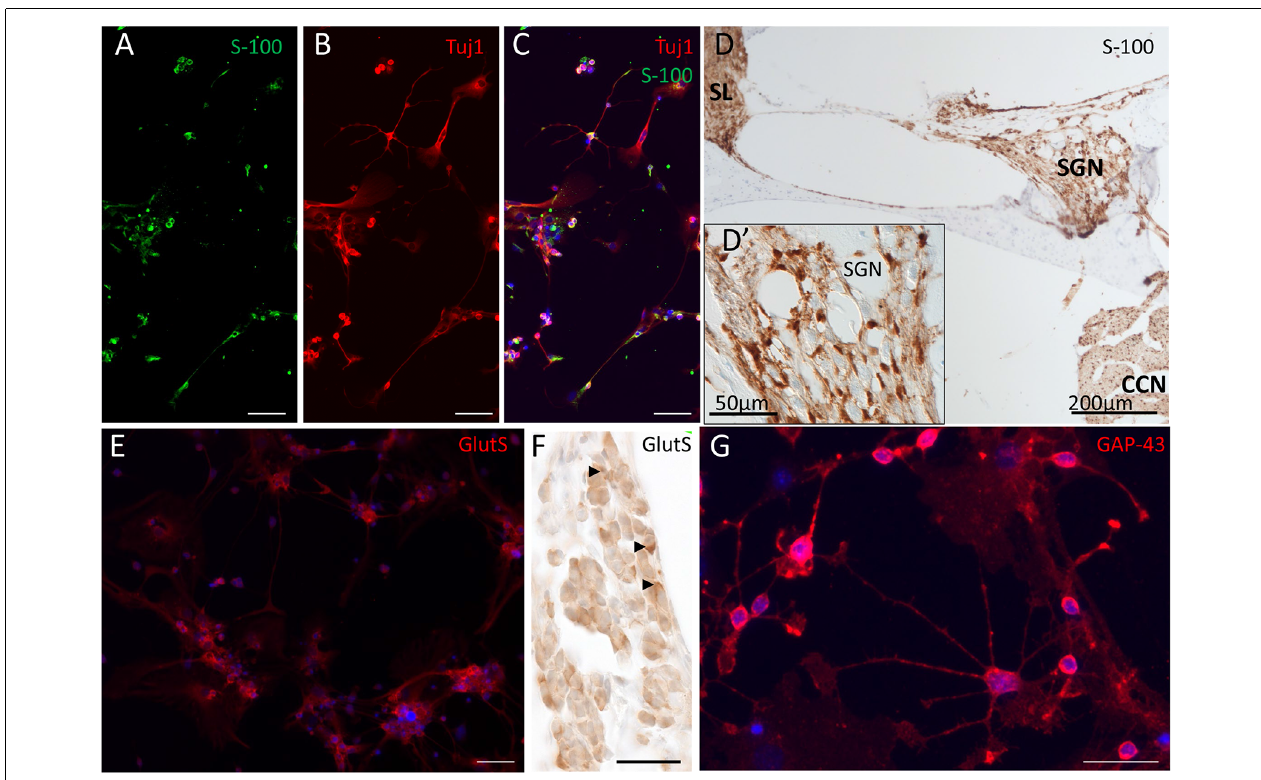
FIGURE 6 | Glial marker expression in differentiated phoenix cells. (A–C) Beta-III-tubulin and S-100 staining 3 days after seeding of phoenix auditory neuroprogenitors. (A) S-100 (green). (B) Beta-III-tubulin (TUBB; red). (C) Composite image with DAPI nuclei staining. (D) S-100 staining in mouse pups cochlear slices. (D (cid:48) ) Inset represents a magnified view of the SGN area and identify Schwann cells as well as satellite glia cells positively stained. (E,F) Glutamine synthetase (GlutS) immunostaining shows presence in several cells mainly in very small satellite cells. (F) Glutamine synthetase in the spiral ganglion of a mouse, 1 day after birth (arrows). (G) GAP-43 immunostaining in differentiating (D3) phoenix cells. Scale bar for (A,B,C,E) = 50 µ m. Scale bar for (F) and (G) = 40 µ